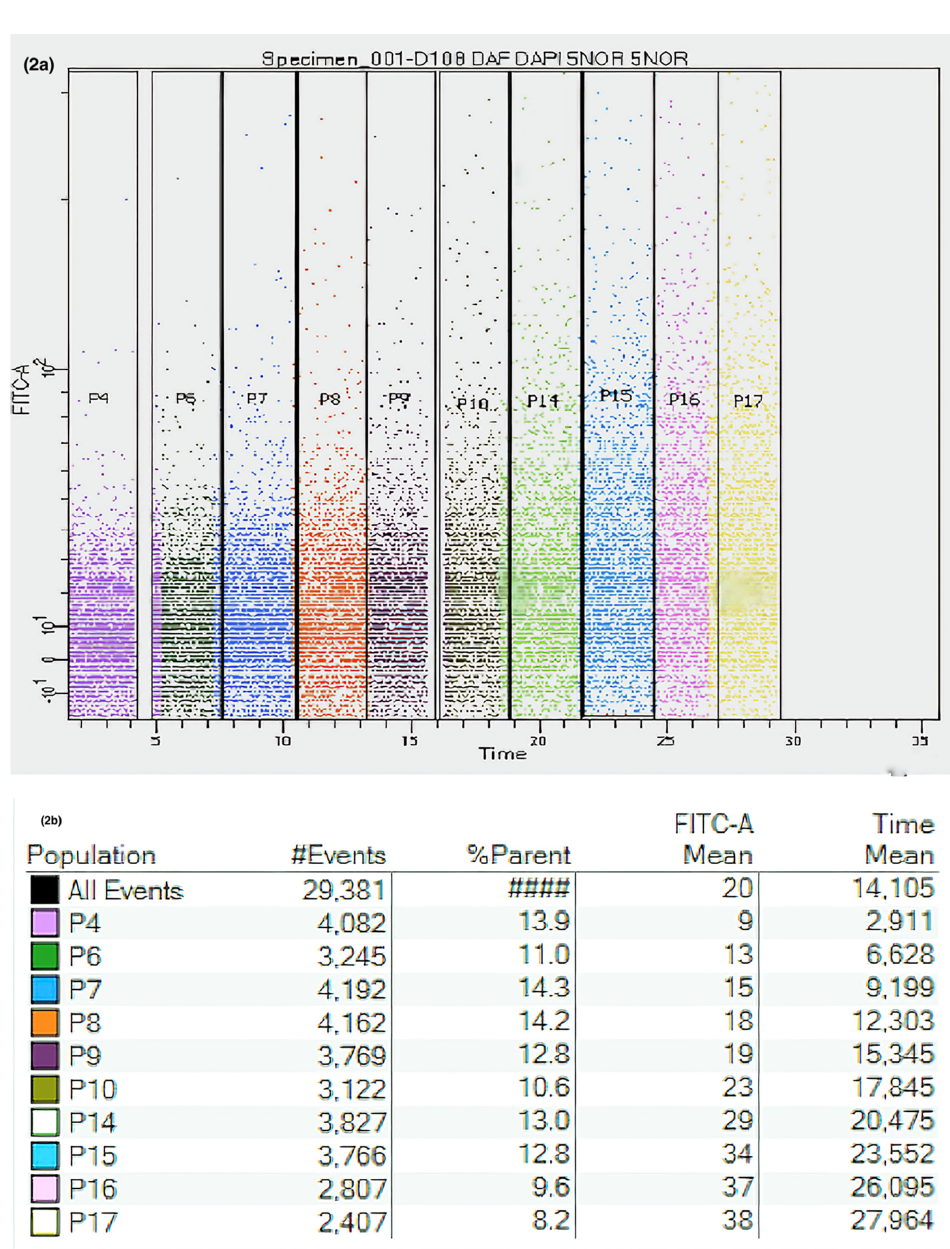
Figure 2. Kinetic measurements of nitric oxide (NO) assays using flow cytometry. ( a ) Dot blot acquired from kinetic measurements. Live nasal epithelial cells were gated according to FSC and SSC, and the gated events were plotted against a FITC-A channel (in this case, DAF-FM DA) and time. ( b ) Table showing gating percentages and fluorescence levels increasing over time.